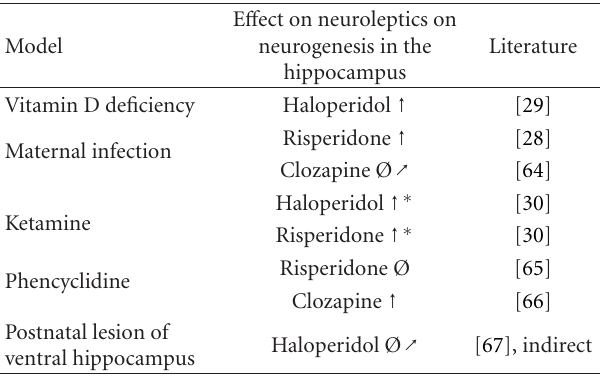
Table 2: Survey of the e ff ects of neuroleptics on hippocampal